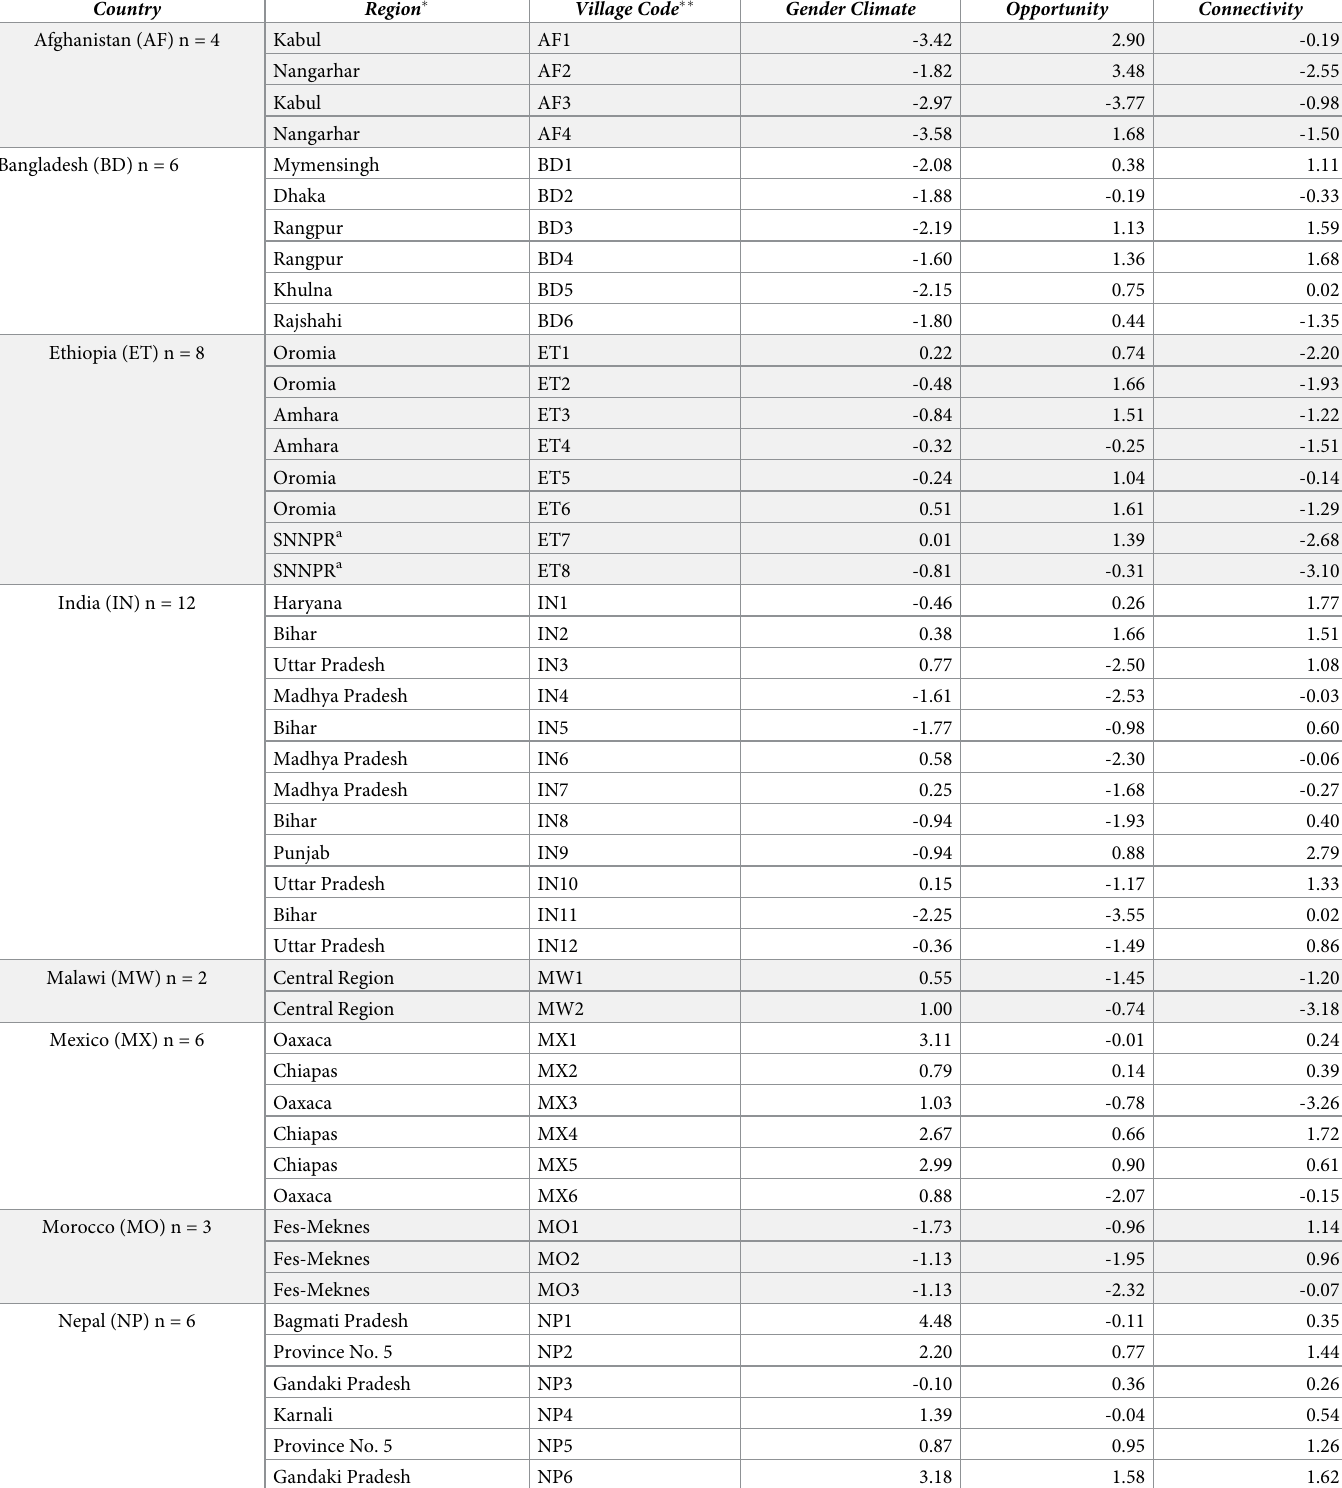
Table 3. Scores of villages according to Gender climate, Opportunity, and